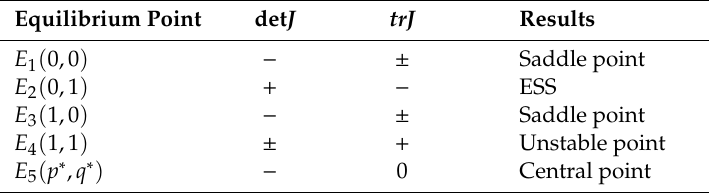
Table 5. The evolutionary stability of local equilibrium points in Case 2. Equilibrium Point det J trJ Results